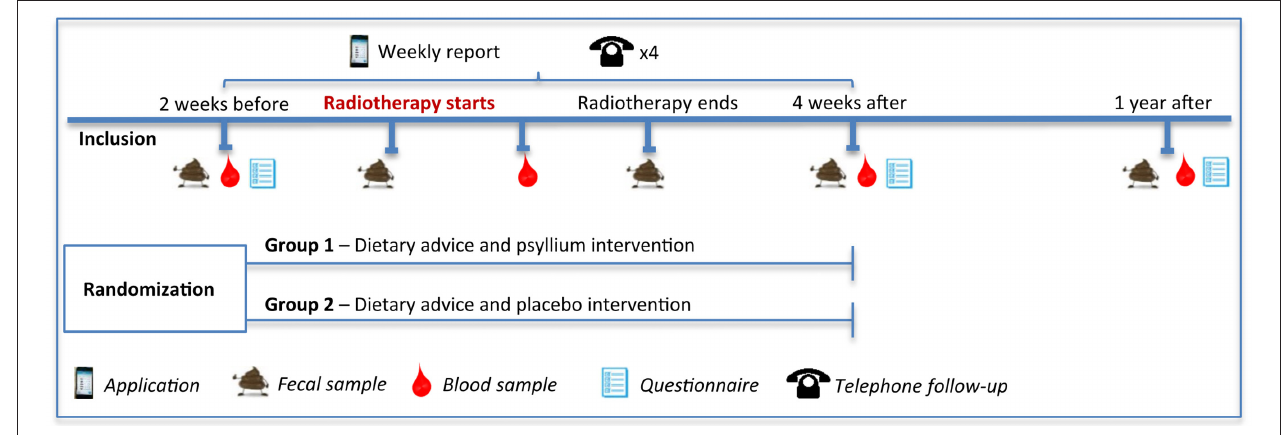
FIGURE 1 | The final study design of the planned main